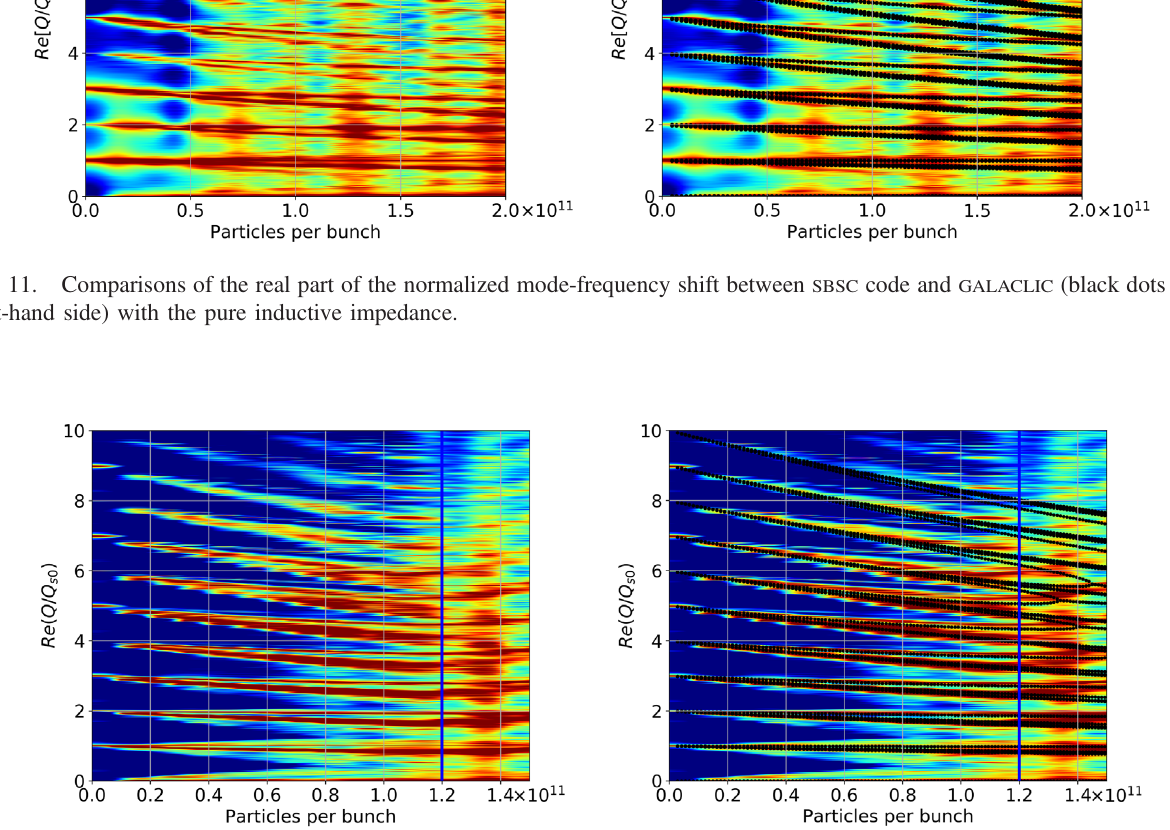
FIG. 12. Comparisons of the real part of the normalized mode-frequency shift between SBSC code and GALACLIC (black dots in the right-hand side) with the BBR